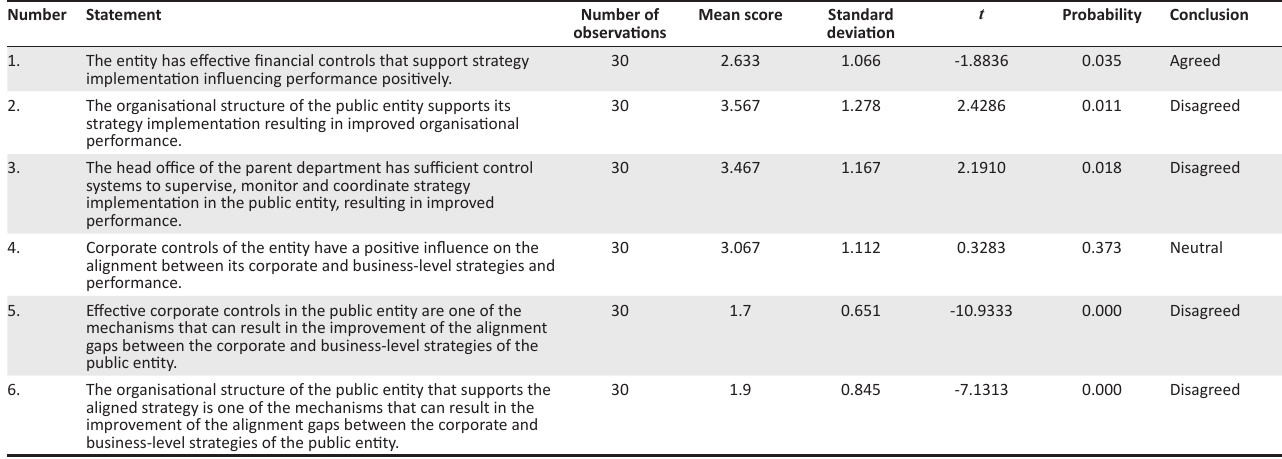
TABLE 1: Role of corporate controls during strategy